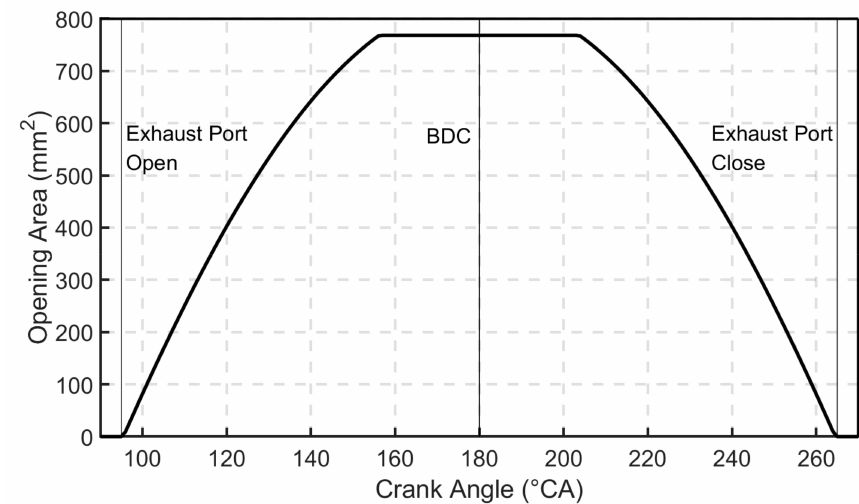
Figure 16. The variation curve of opening area with crank angle (exhaust port).